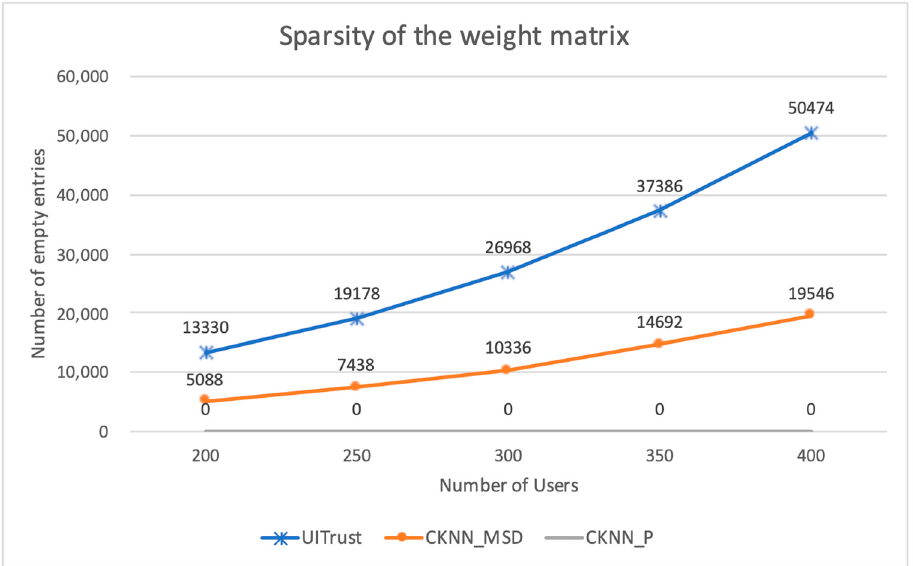
Figure 5. Sparsity of the weight matrices versus the number of users.